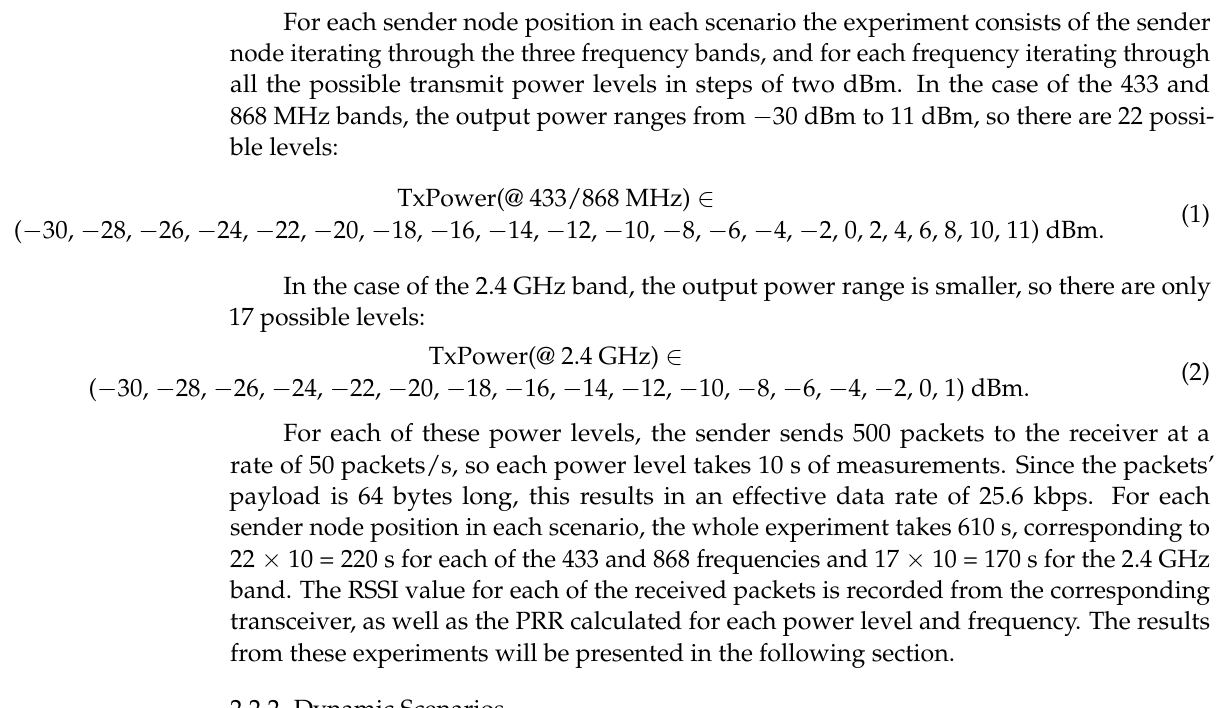
Figure 2. Standing scenario, with the receiver node on the left hip and sender nodes on the right wrist ( a ) and right ankle ( b ). Sitting scenario, with the receiver node on the left hip and sender nodes on the right wrist ( c ) and right ankle ( d ).